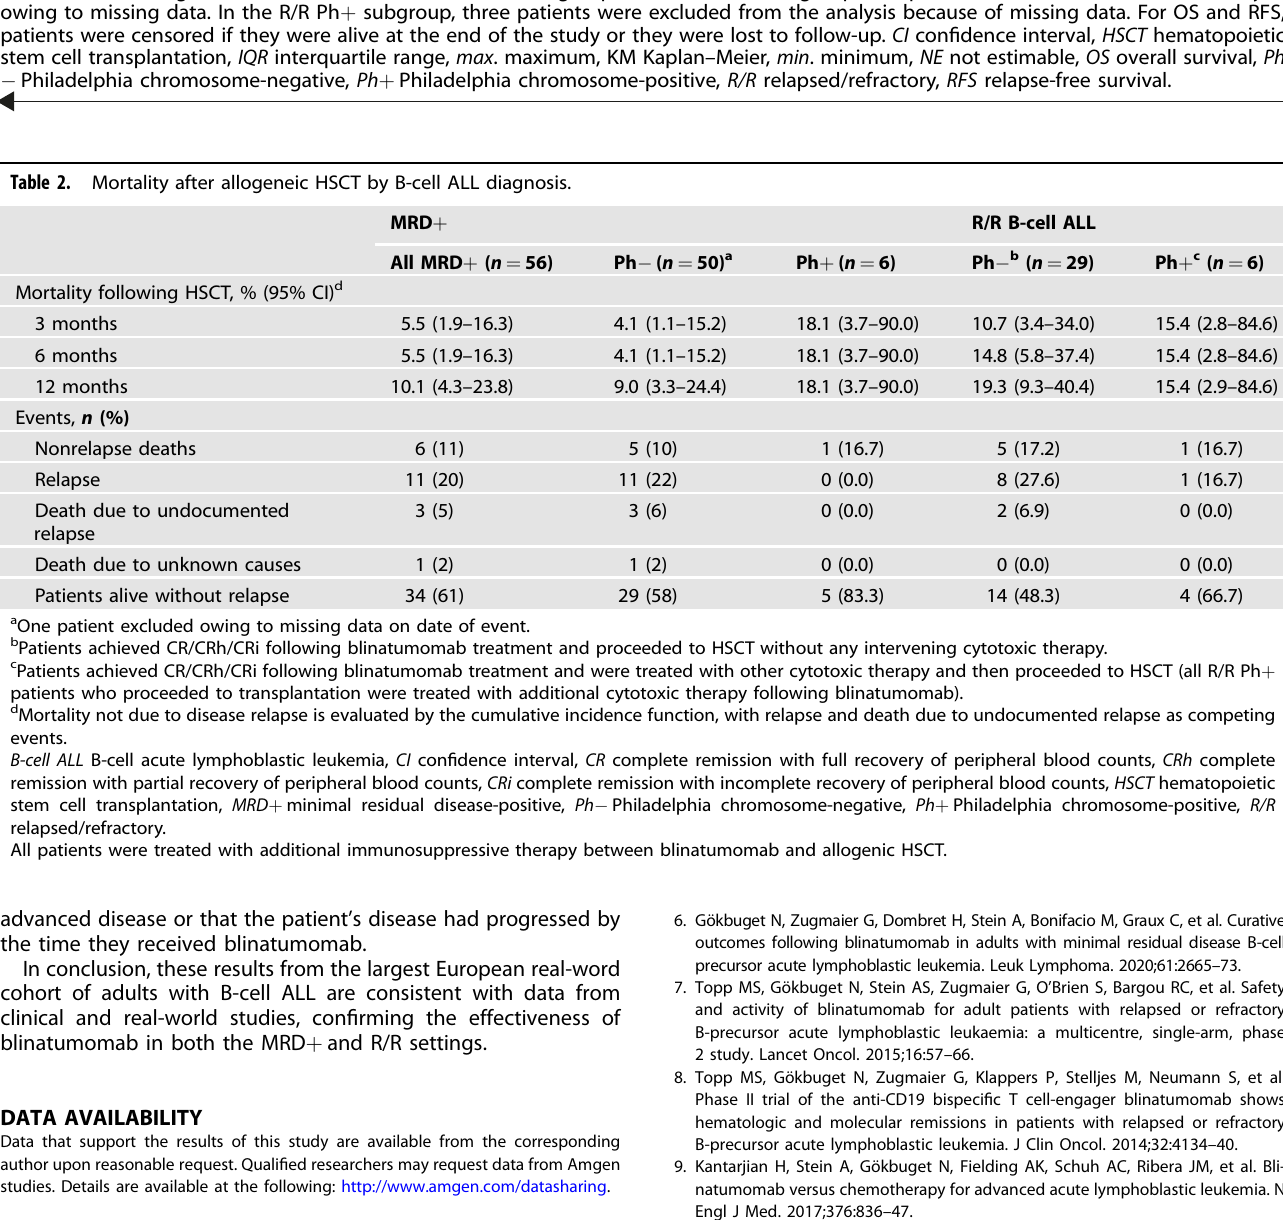
Fig. 3 KM analysis of OS and RFS in the R/R Ph − and R/R Ph + subgroups. A Time-to-event analysis for OS in the R/R Ph − subgroup. B OS with additional censoring at the time of HSCT in the R/R Ph − subgroup. C Time-to-event analysis for RFS in the R/R Ph − subgroup. D RFS with additional censoring at the time of HSCT in the R/R Ph − subgroup. E Time-to-event analysis for OS in the R/R Ph + subgroup. F OS with additional censoring at the time of HSCT in the R/R Ph + subgroup. G Time-to-event analysis for RFS in the R/R Ph + subgroup. H RFS with